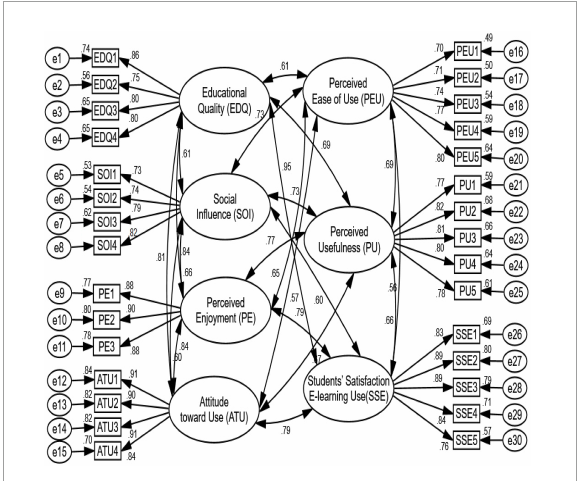
FIGURE3 Structural model ( P